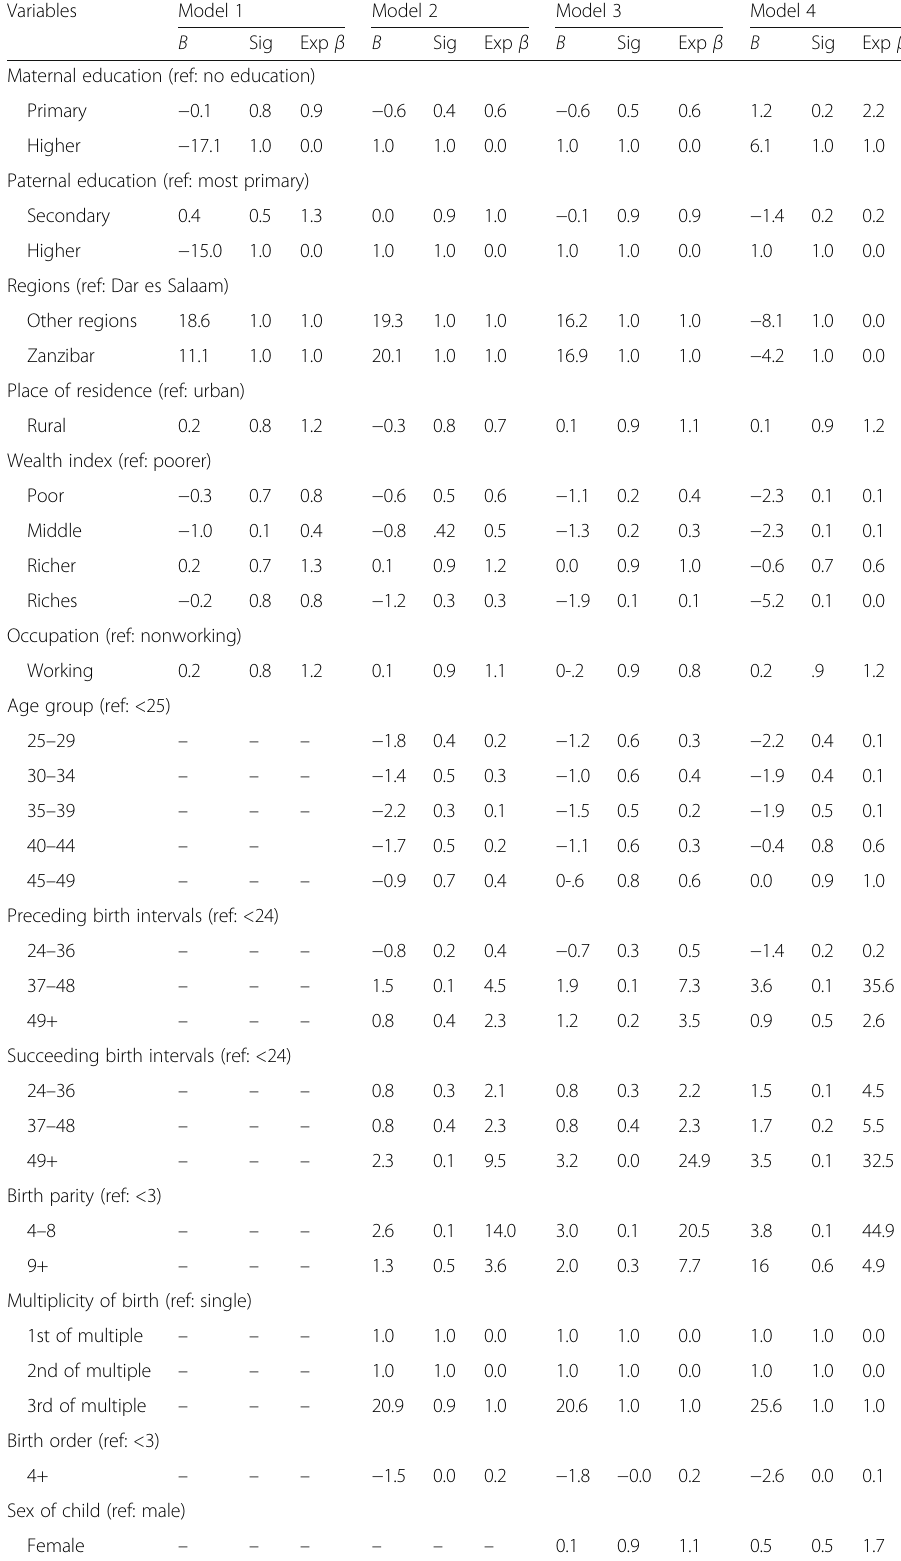
Table 4 Odds ratios of child mortality with multiple predictors in Tanzania 2011 – 2015